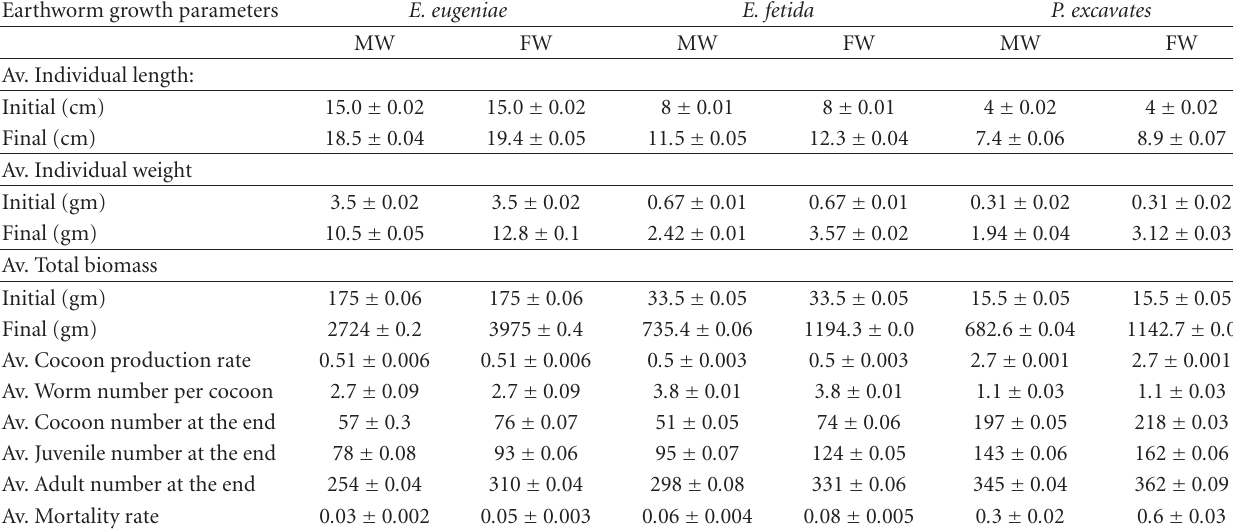
Table 1: Growth parameters of three earthworm species during the process of vermicomposting of MW and FW. Earthworm growth